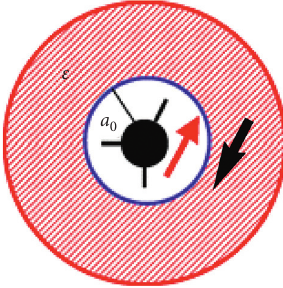
Figure 3: Onsager (dipole and sphere) model [34].